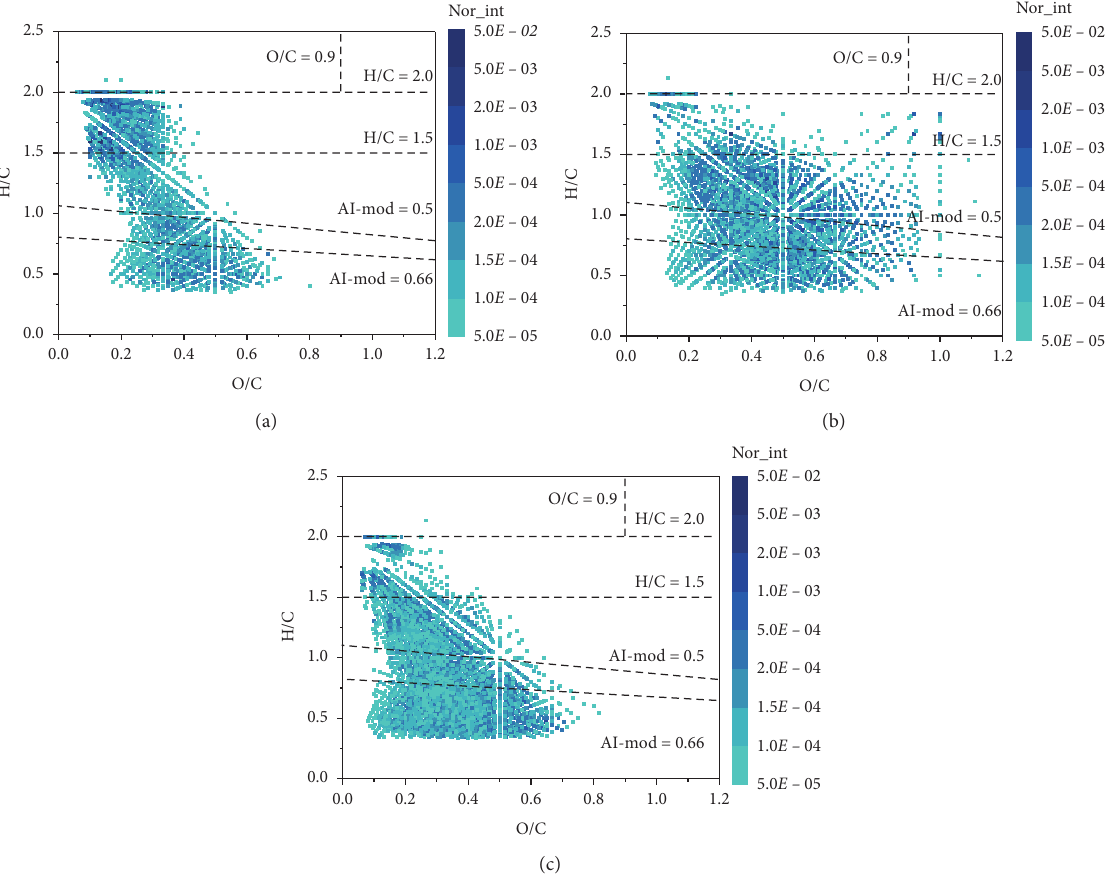
Figure 1: Van Krevelen diagrams from the mass spectra of (a) humic acids from Jiufeng forest soil, (b) humic acids from Suwannee River, and (c) humic acids from leonardite. The shades of color represent the peak magnitudes of the molecules. Broken lines divide the pattern into 7 areas which indicate major biomolecular compound classes: (1) polycyclic aromatics (PCAs, AI-mod > 0.66), (2) highly aromatic compounds (0.66 ≥ AI-mod > 0.50), (3) highly unsaturated compounds (AI-mod ≤ 0.50 and H/C < 1.5), (4) unsaturated aliphatic com- pounds (2.0 > H/C ≥ 1.5 and N � 0), (5) unsaturated aliphatic compounds containing N (2.0 > H/C ≥ 1.5 and N > 0), (6) carbohydrates (H/ C ≥ 2.0 and O/C ≥ 0.9), and (7) fatty acids and sulfonic acids (H/C ≥ 2.0 and O/C < 0.9). Nor_int is the normalization of the intensity of each molecule.